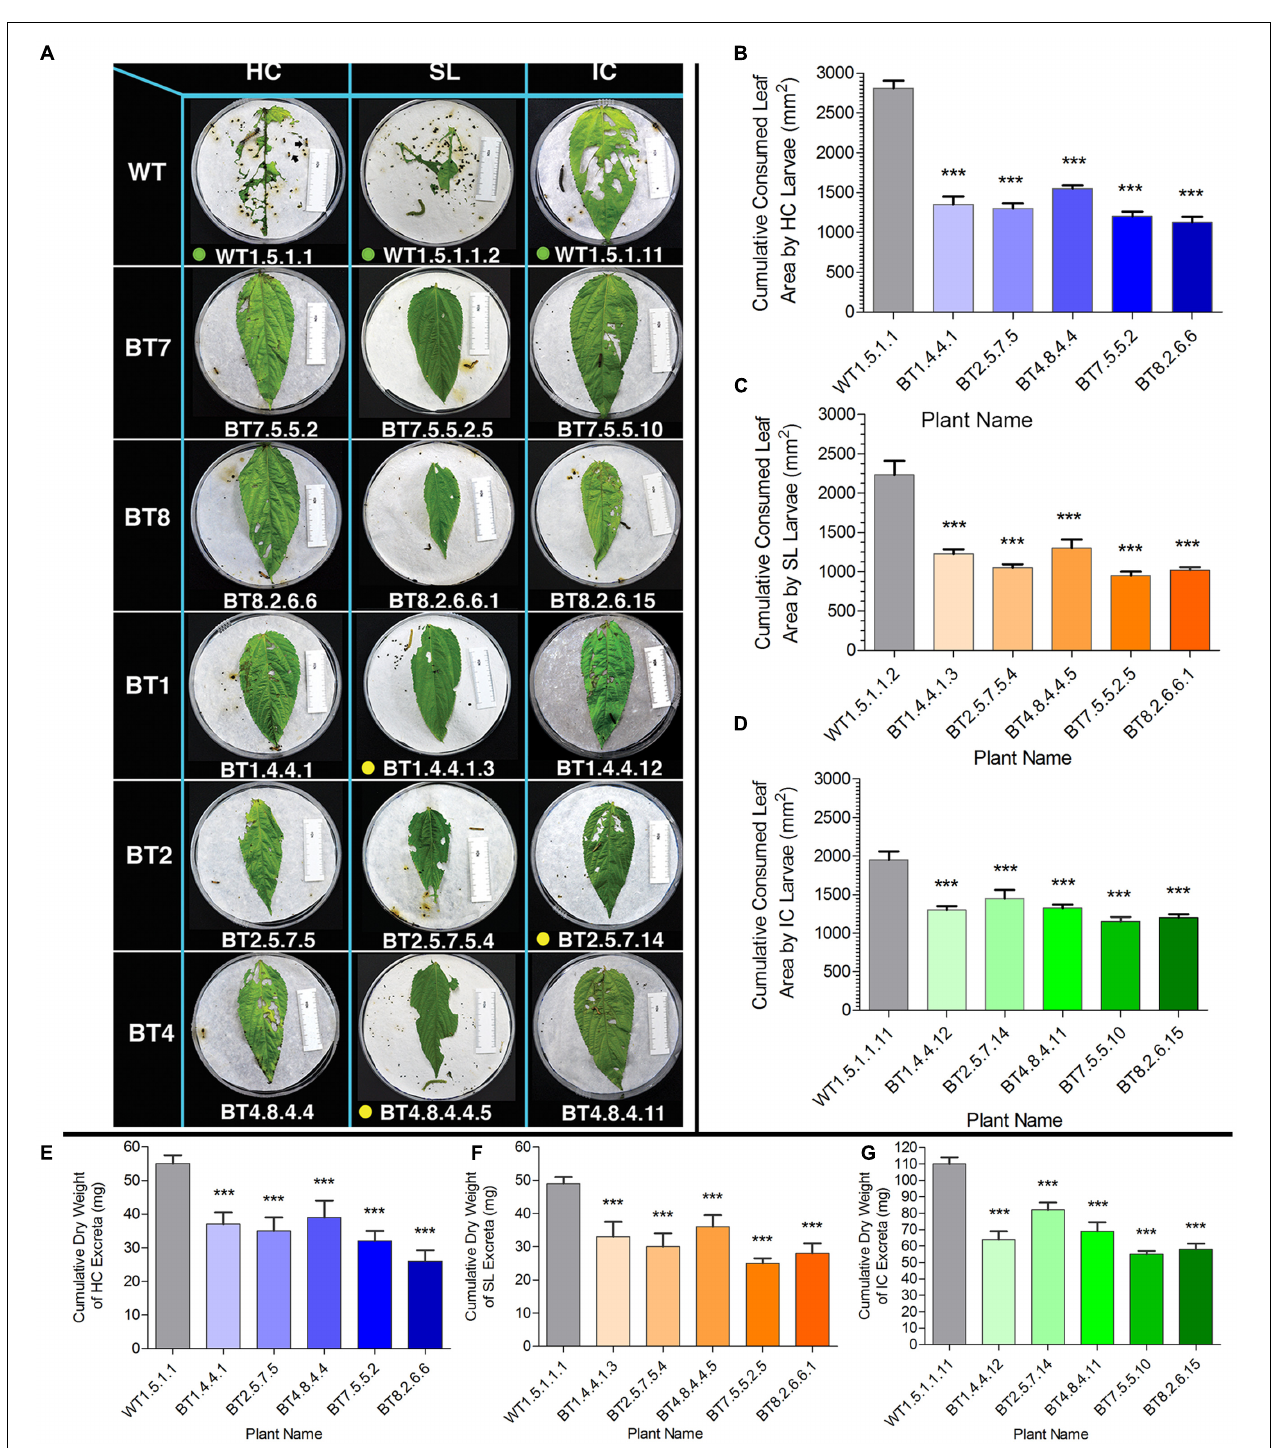
FIGURE 6 | Comparative analyses of leaf area consumption and dry weight of excreta after detached leaf bioassay (DLB) by SL, HC and IC larvae. (A) Representative photograph of HC, SL and IC after 96 h of feeding (when maximum mortality was observed). Larvae consumed more leaf area of WT than transgenic plants. Here green dots signify alive larvae, yellow dots for paralyzed and no dots for dead larvae. The length of the white ruler in the picture is of 50 mm and size of petri plate is 140 mm. Arrows in WT set of HC indicate parts of head molting during larval development. (B–D) Cumulative leaf area consumption by 5 larvae for each plant. (E–G) Cumulative difference in dry weight of larval excreta after feeding on WT and Bt jute in DLB. SE was calculated from 2 biological replicates. Significant difference ( P < 0.001) denoted as ∗∗∗ in transgenics compared to WT.